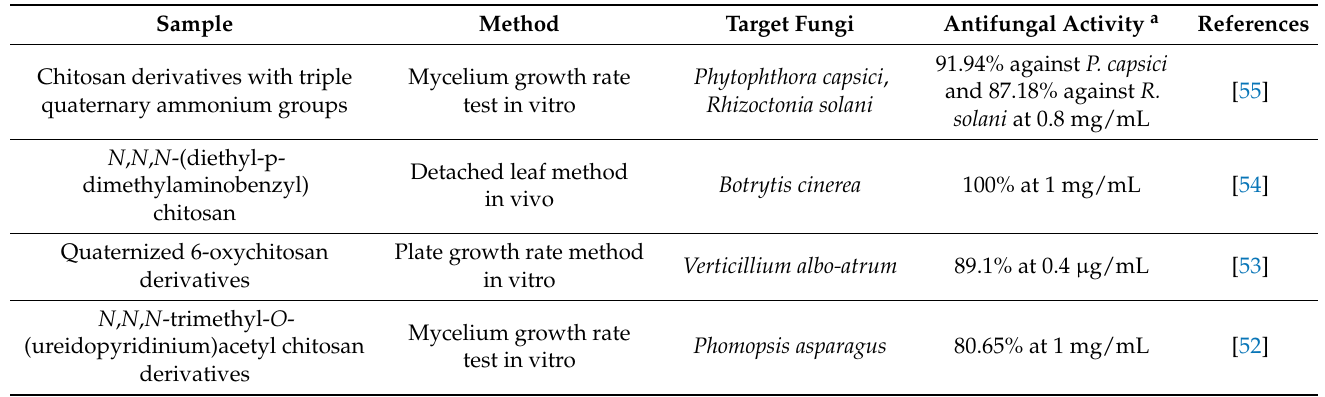
Table 3. Antifungal properties of some chitosan quaternary ammonium salts.